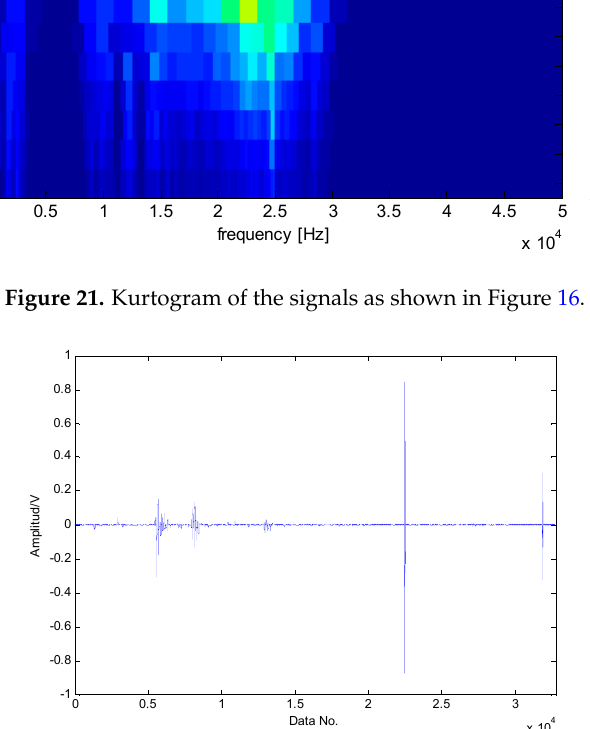
Figure 22. The transient impact component using TQWT. Sensors 2016 , 16 , 1524